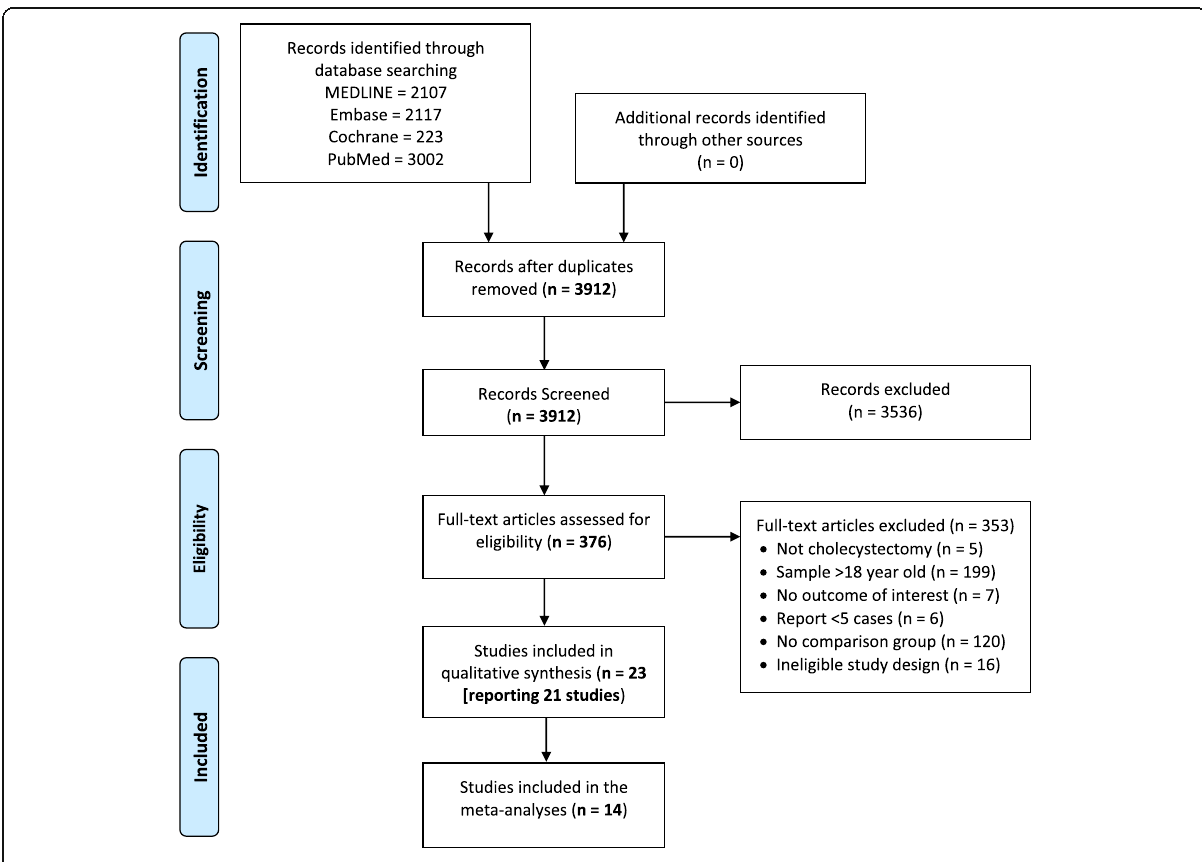
Fig. 1 PRISMA flow chart of included